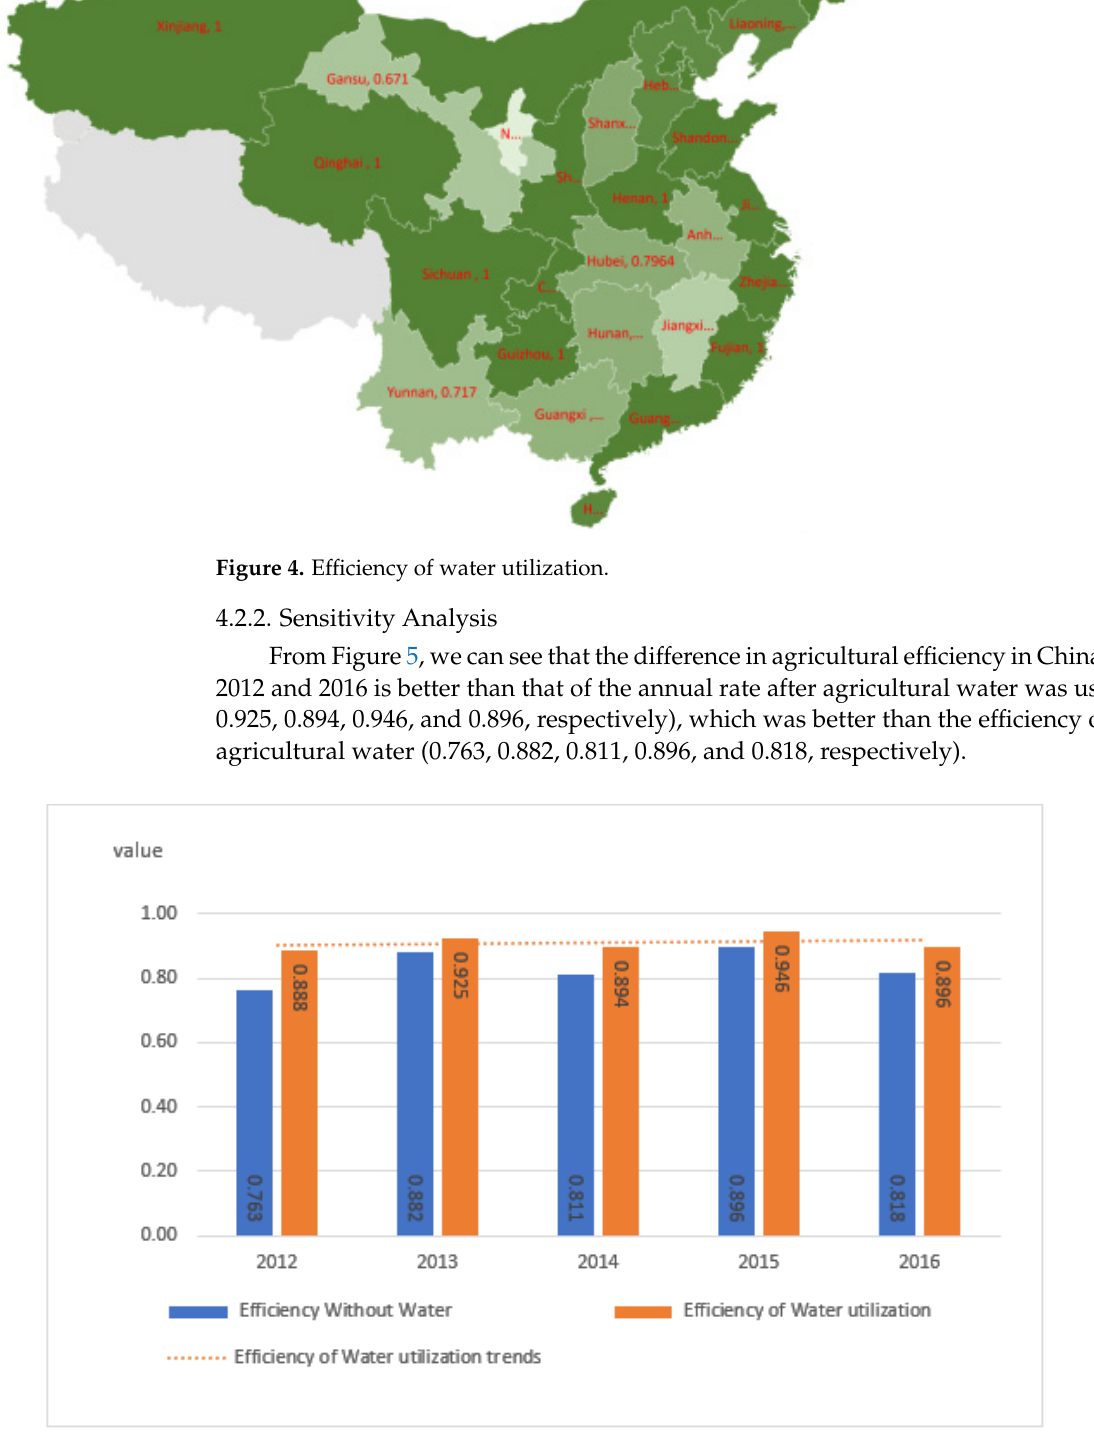
Figure 5. Di ff erences in agricultural e ffi ciency in China. Data source: compiled by this study. Figure 5. Differences in agricultural efficiency in China. Data source: compiled by this After the input of agricultural water, the overall average e ffi ciency of agriculture in- creased from 0.834 to 0.910. The overall e ffi ciency value of the 10 administrative regions of Beijing, Heilongjiang, Shanghai, Jiangsu, Zhejiang, Fujian, Shandong, Sichuan, Qinghai, and Xinjiang has always been 1, and their e ffi ciency performance is not a ff ected by agri- cultural water use. They still have the best agricultural e ffi ciency performance (see Ap- pendix A). After the input of agricultural water, the agricultural e ffi ciency of the 17 administra- tive regions of Tianjin, Hebei, Shanxi, Inner Mongolia, Liaoning, Jilin, Anhui, Henan, Hu- bei, Hunan, Guangxi, Hainan, Chongqing, Guizhou, Yunnan, Shaanxi, and Gansu was seen to have increased. The agricultural e ffi ciency value of Jilin rose from 0.545 to 1, or an increase of 83.52%, and Chongqing, Inner Mongolia, Shaanxi, and Hubei also increased by 47.21%, 32.10%, 31.72%, and 28.15%. They are the fi ve administrative districts with the most e ffi ciency gains, indicating that agricultural water use is positive for their e ffi ciency. However, the agricultural e ffi ciency of Jiangxi and Ningxia declined by 2.42% and 10.49%, and it is necessary to manage agricultural water in particular to improve their overall ef- fi ciency of agriculture (see Figure 6).